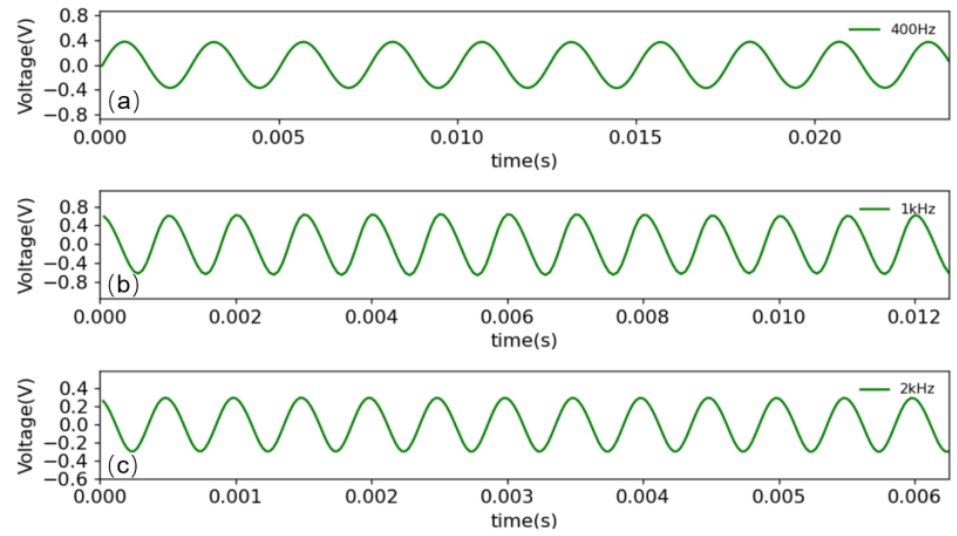
Figure 4. The structure of CV-CNN-LSTM model for speech enhancement.